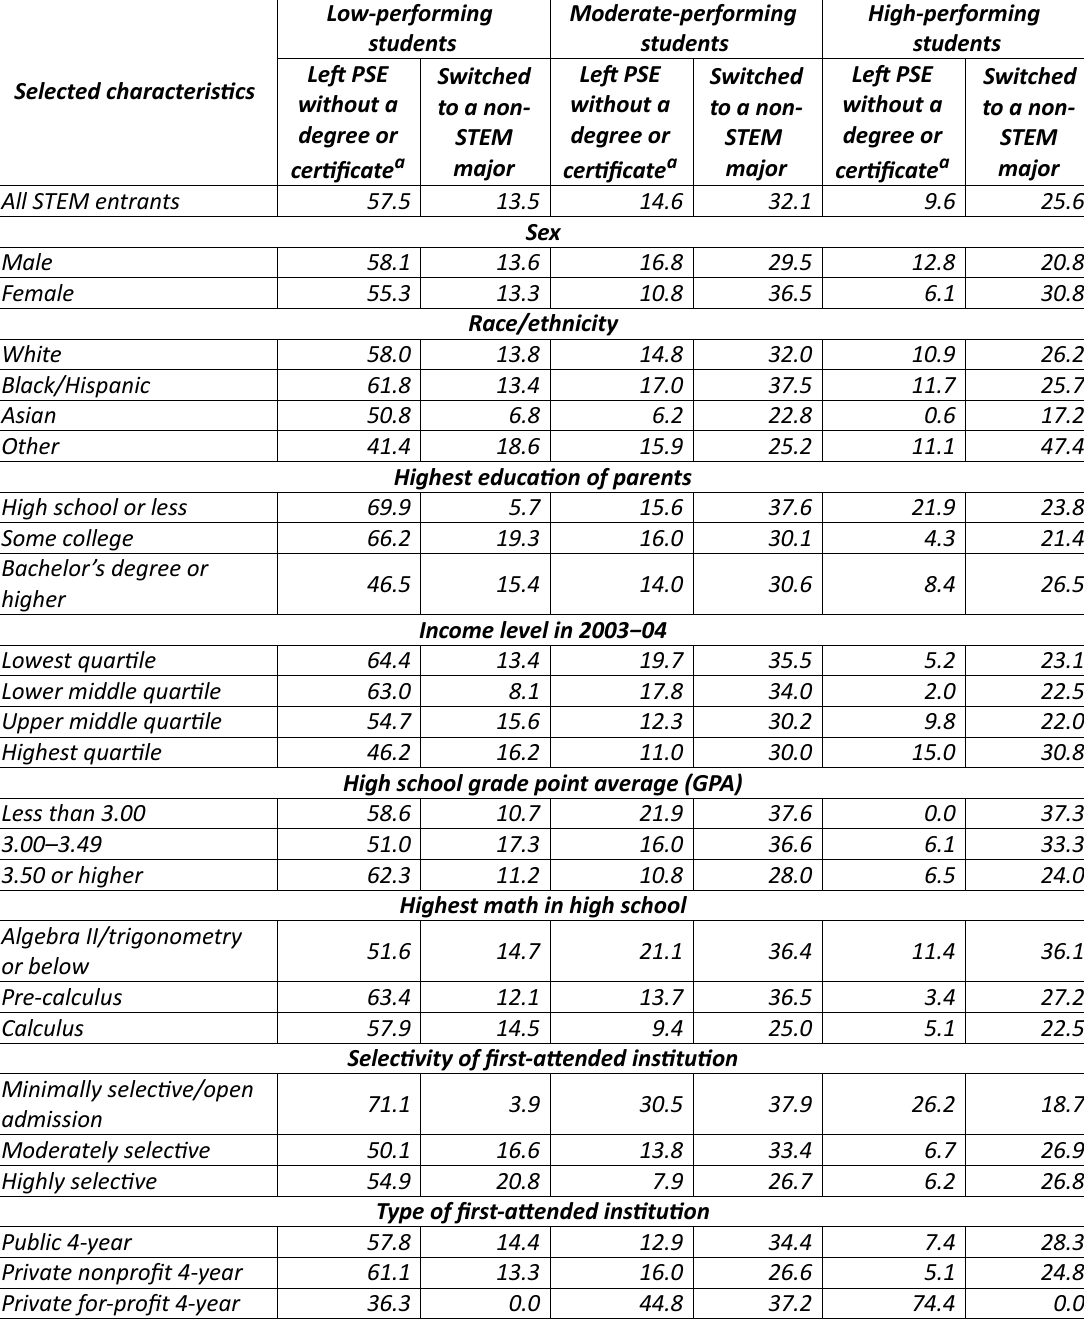
Table 3. Characteristcs of STEM entrants who lef STEM